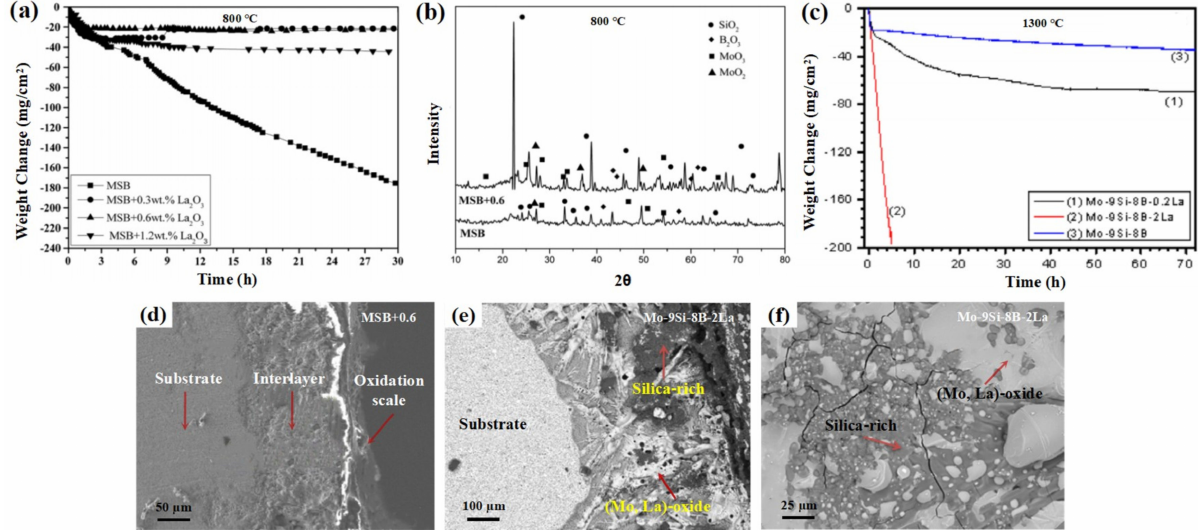
Figure 2. Weight change curves of various samples oxidized at different temperatures ( a , c ); surface and cross-sectional SEM/BSE images of various samples oxidized at different conditions: 800 ◦ C ( d ) with corresponding surface XRD analysis results ( b ), 1200 ◦ C for 2 h ( e ), and 1300 ◦ C for 23 h ( f ). ( a , b , d ) and ( c , e , f ) reproduced with permissions from [80] and [60], respectively. Copyright 2011 Elsevier and 2014